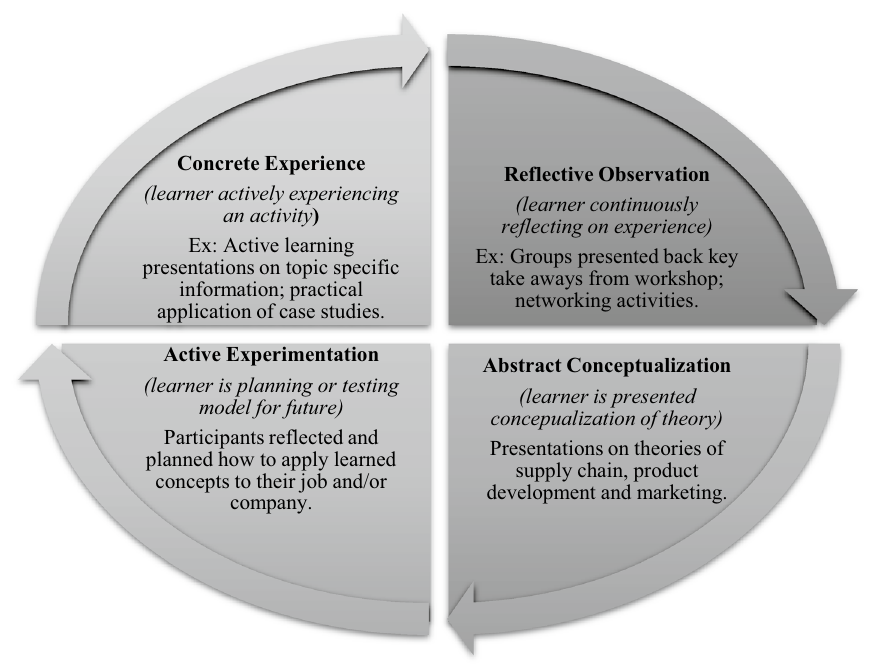
Fig. 1 Kolb’s experimental learning cycle based on Healey and Jenkins (2000) and how each stage was used to build the workshops’